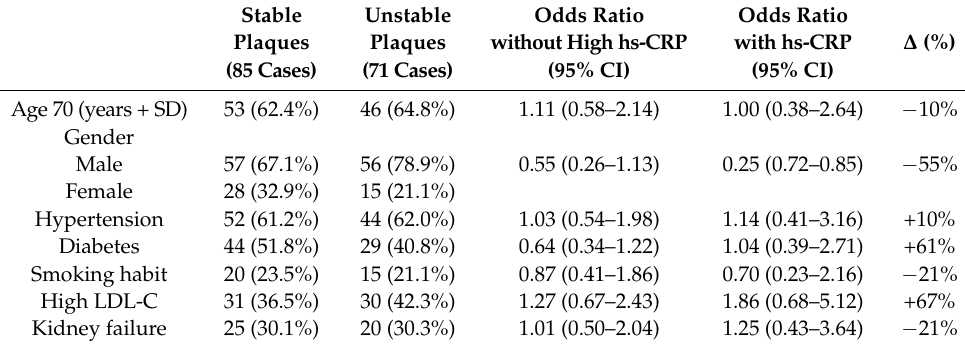
Table 2. Plaque instability and risk